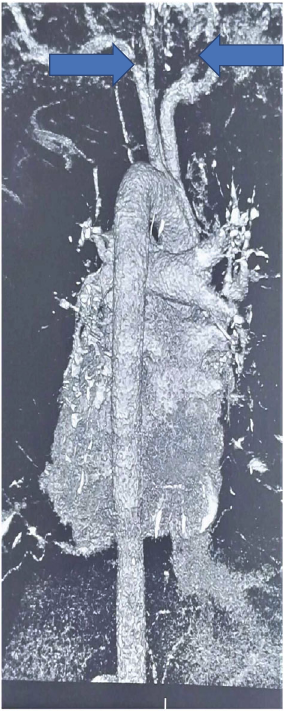
Figure 1: Computed tomography and pulmonary angiography of the chest in the index patient showing near complete occlusion of both right and left pulmonary